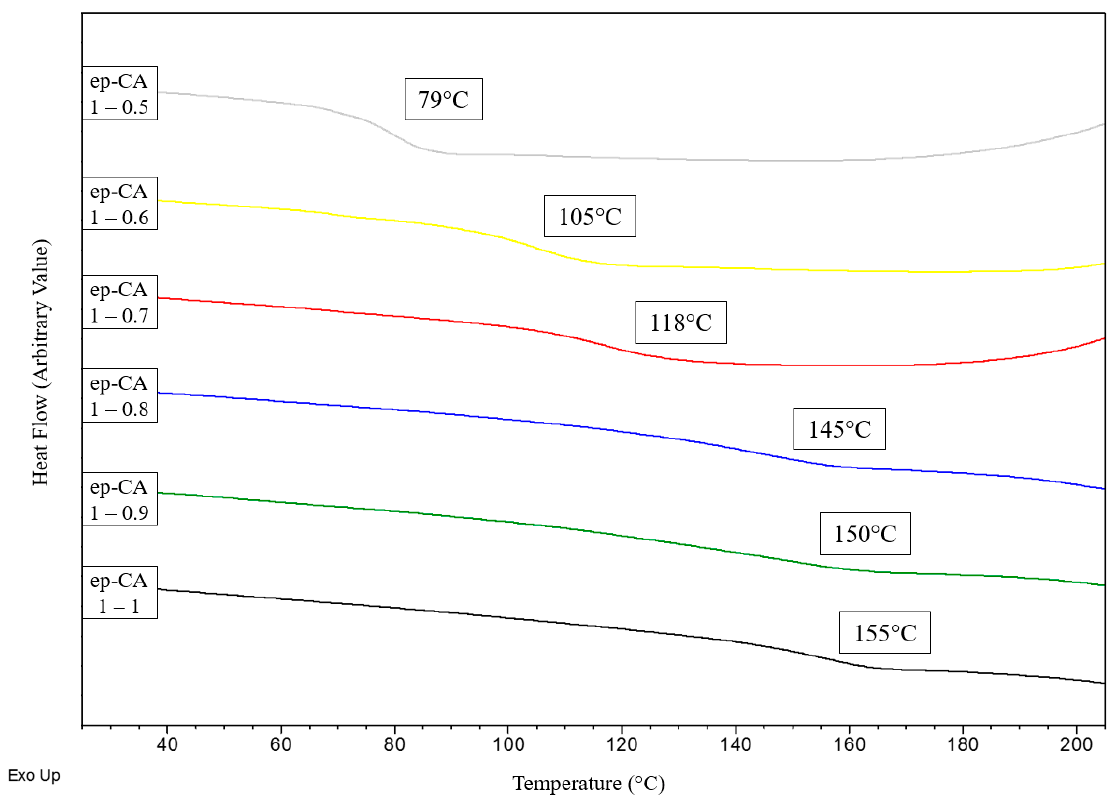
Figure 3. Effect of the epoxide function/CA ratio on the glass transition determined by DSC.